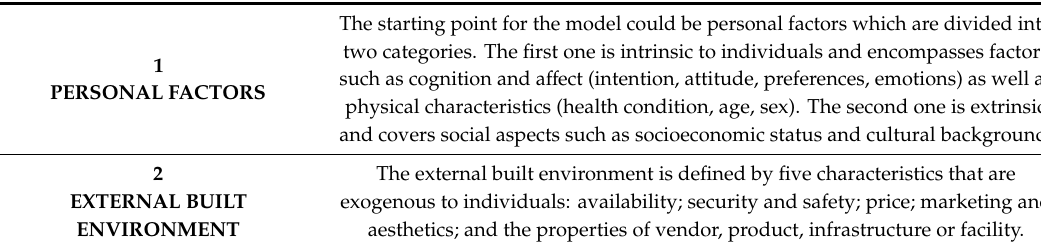
Figure 3. Conceptual model depicting the interactions between the built environment, individuals and their behaviors.